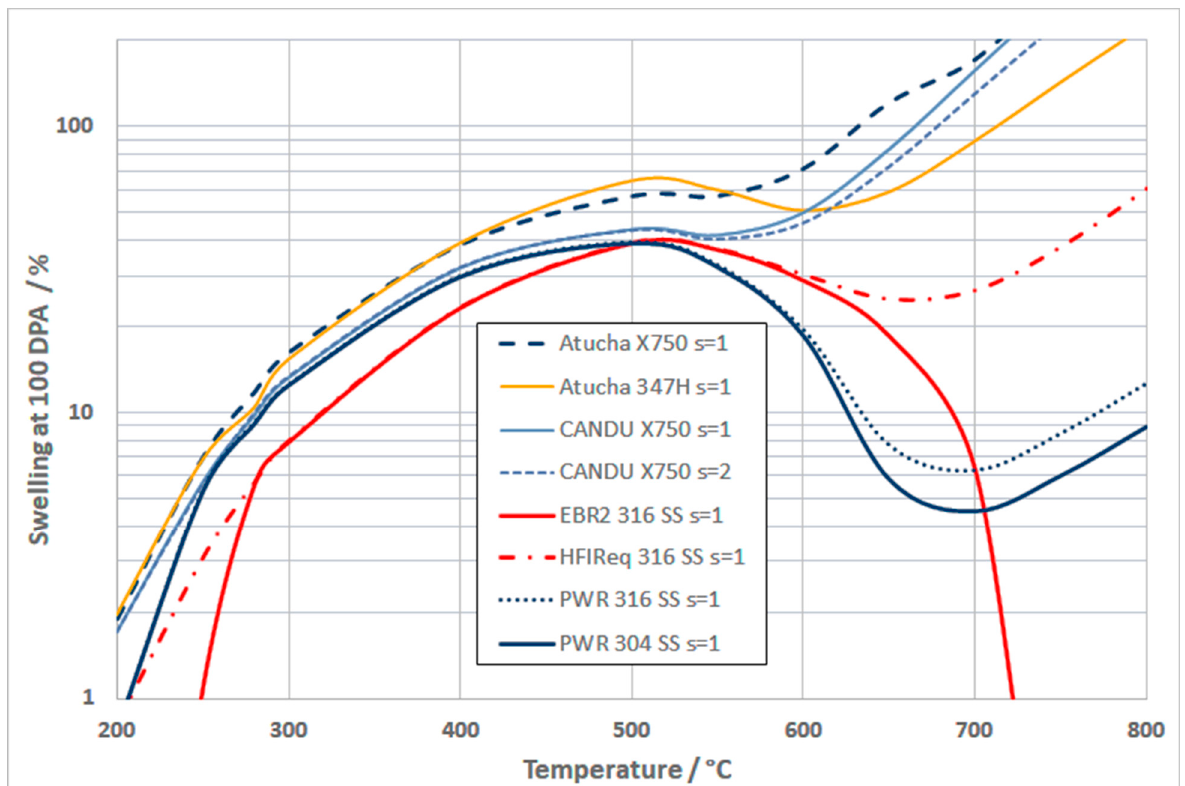
Figure 8. Swelling at 100 DPA for different alloys in different reactor cores as afunction of temperature. The surface energy, s, shown in the legend refers to either 1 or 2 J.m − 2 (see text). Table 3. He/DPA for different alloys irradiated in various reactors.